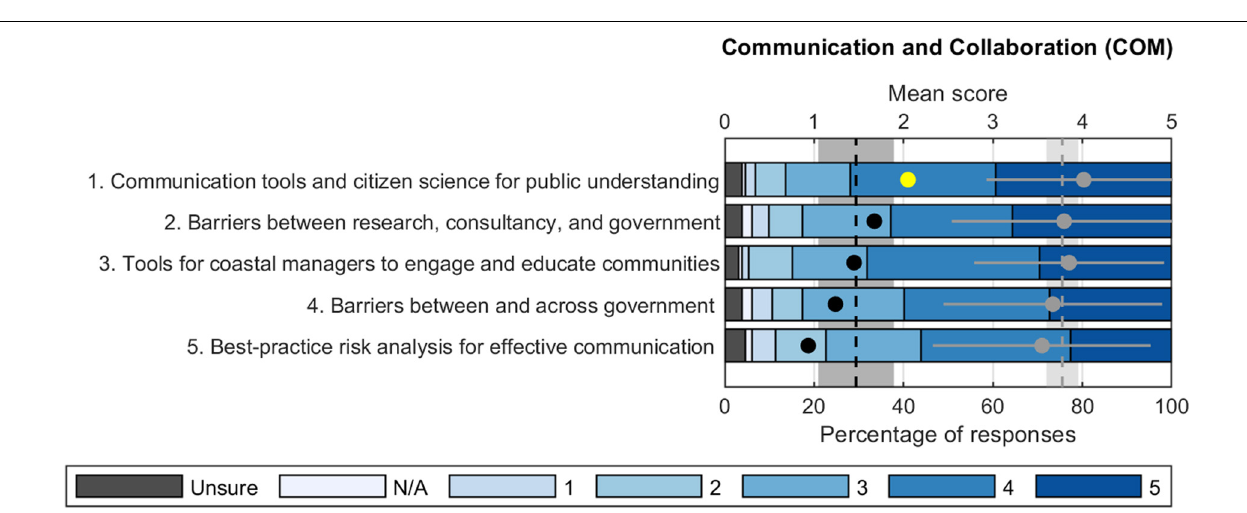
Frontiers in Marine Science |